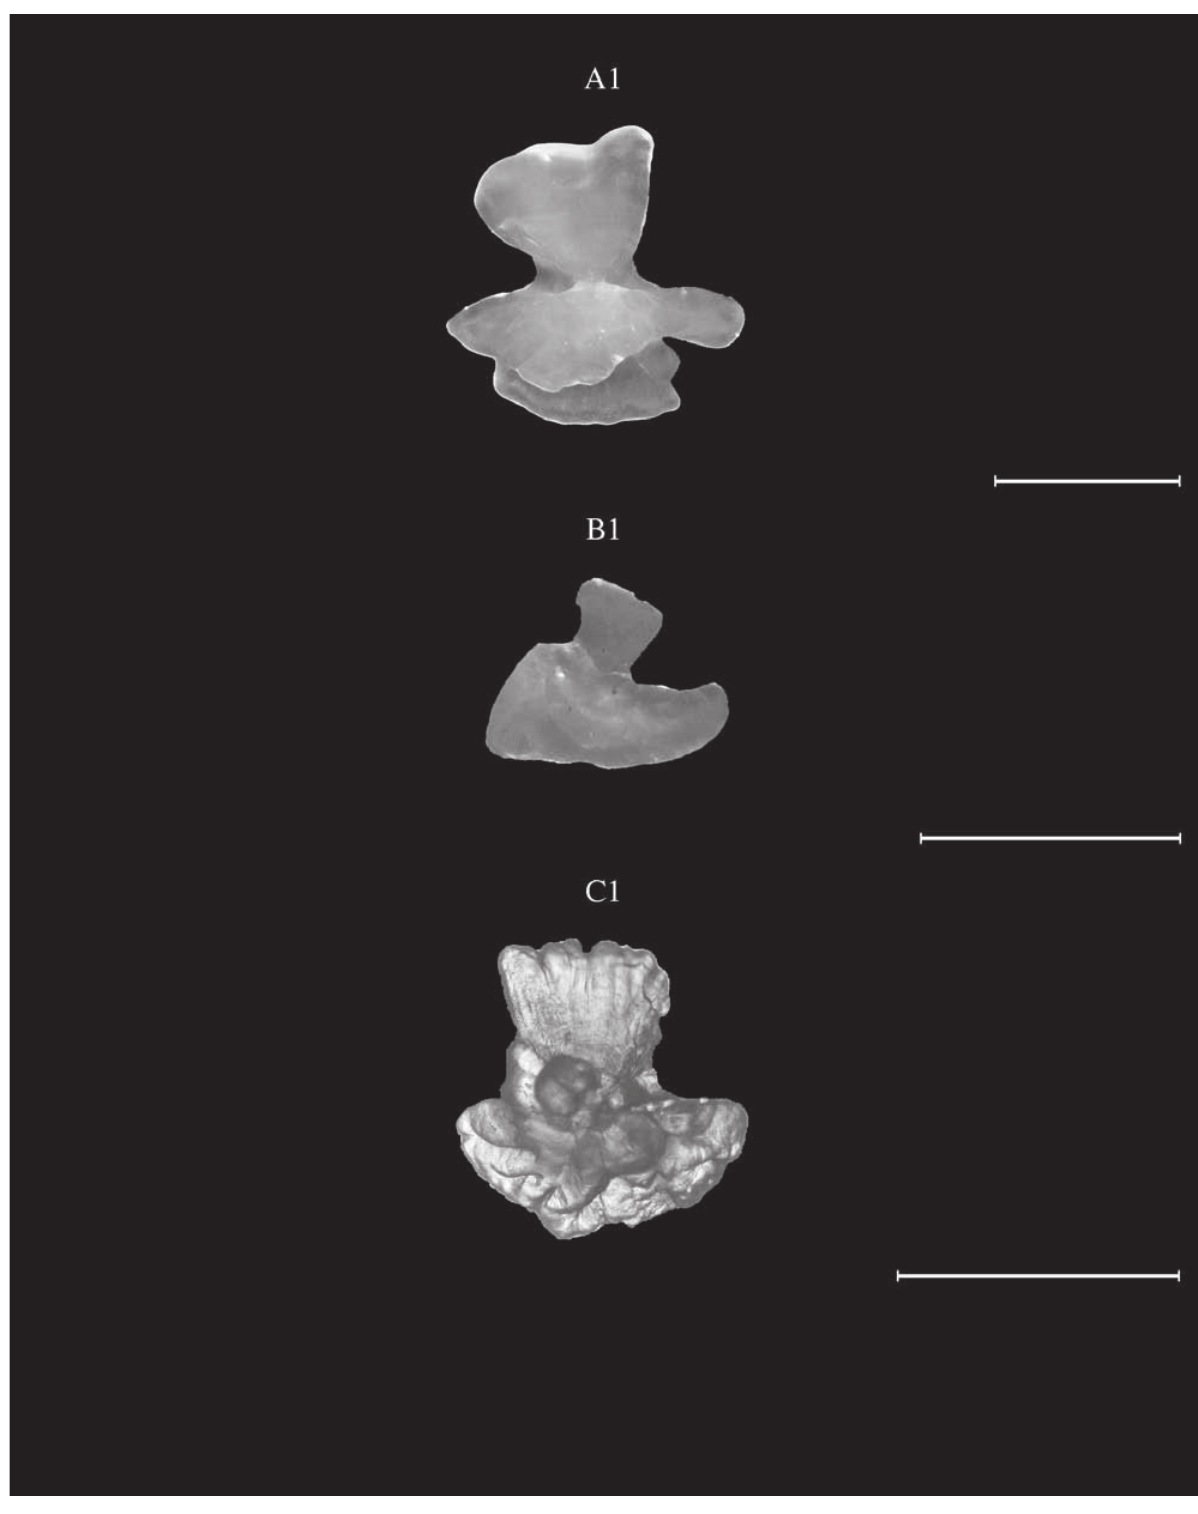
Fig. 96. – Stephanolepis hispidus (CEA). TL: A1, 13.5 cm. Canthigaster capistrata (CEA). TL: B1, 8.3 cm. Lagocephalus lagocephalus (CEA). TL: C1, 37.2 cm. Scale bar = 1